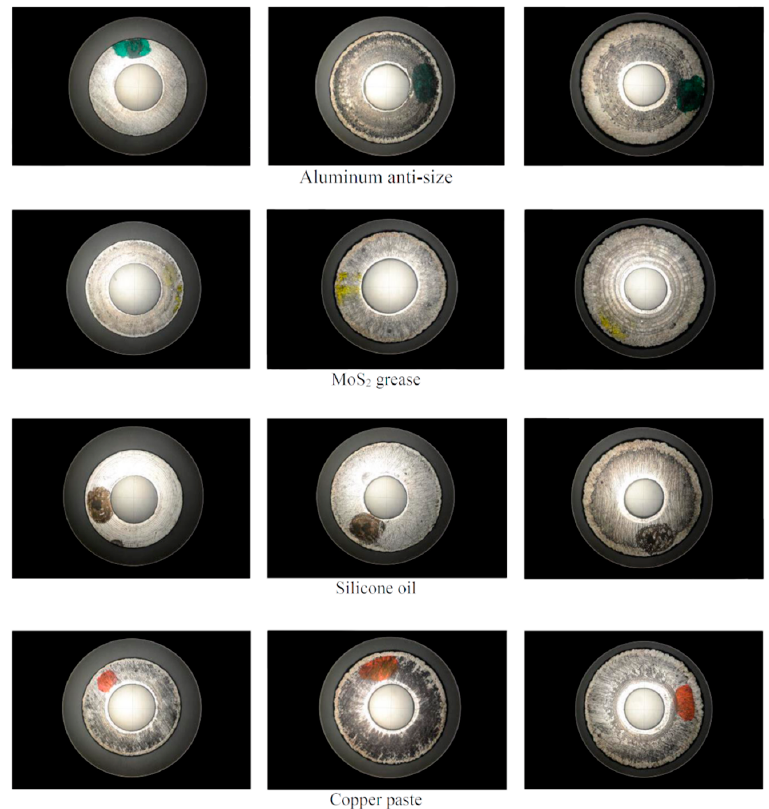
Figure 11. Rings tested in the laboratory after each forming stage. Images obtained by TESA VISIO profile projector.